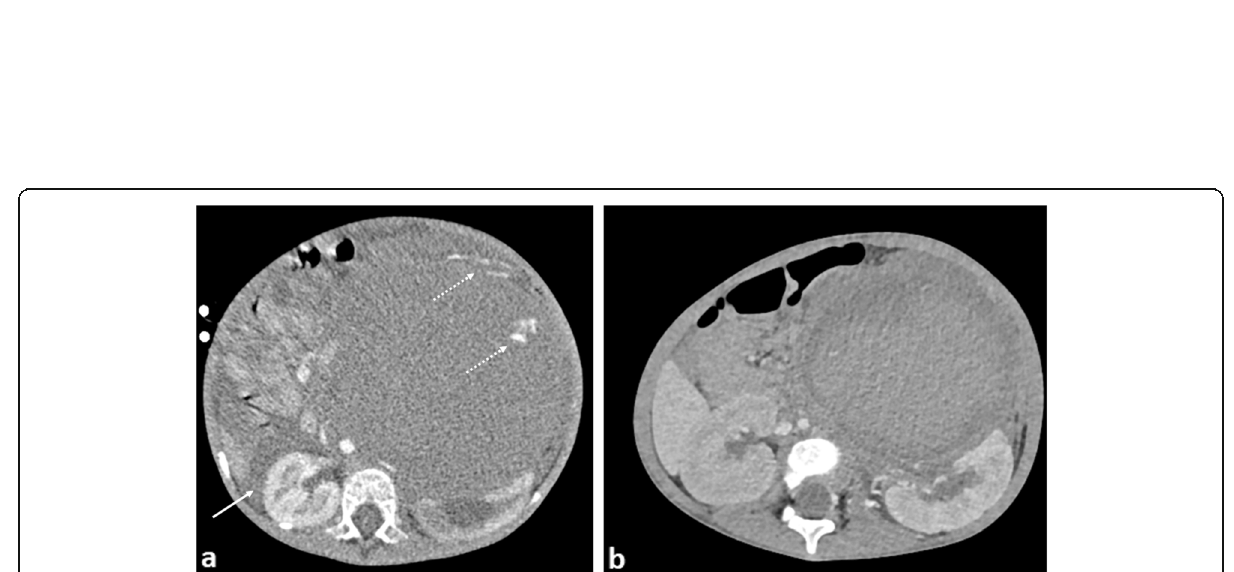
Fig. 20 A 3-year-old girl with stage 4 neuroblastoma and acute intra-tumoural haemorrhage. a Axial CT imaging obtained during an episode of acute abdominal pain and drop in haemoglobin shows a large left suprarenal mass with right paracolic free fluid (white arrow) and a blush of contrast within the peripheral left aspect of the mass (dashed arrow) in keeping with active contrast extravasation. b A repeat CT image obtained after vascular embolisation 1 month later reveals reduction in the size of the mass with organisation of the haematoma. The degree of left renal hydronephrosis also appears reduced